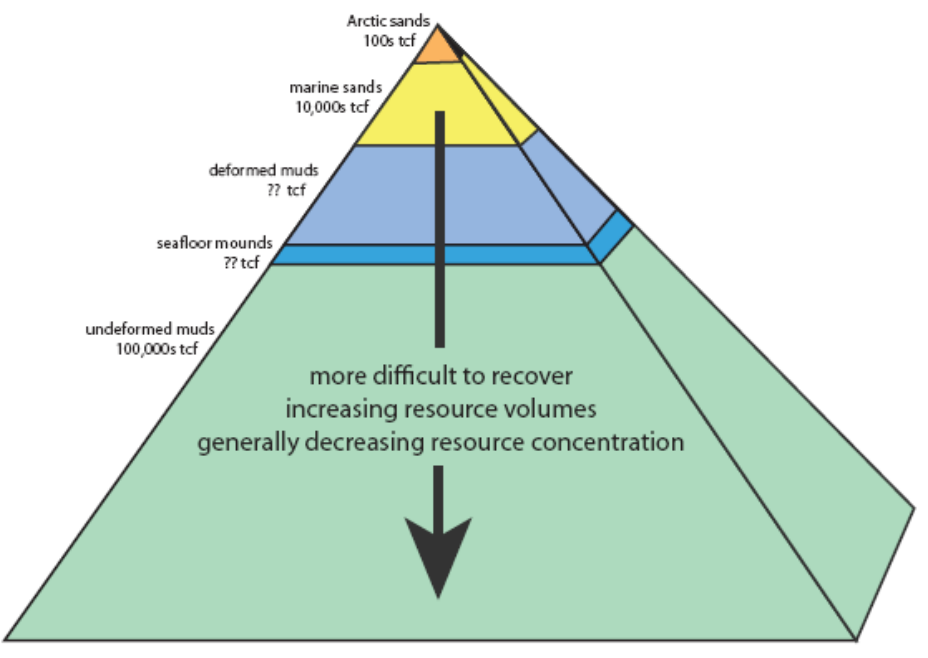
Figure 2. Gas Hydrate Resource Pyramid (modified after Boswell et al.